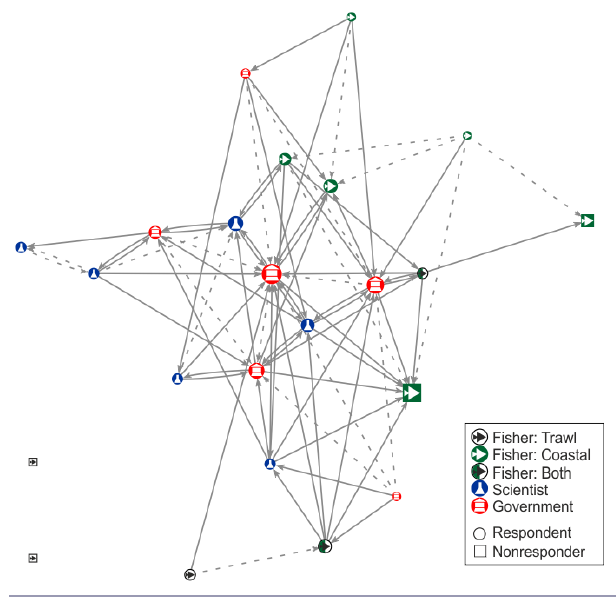
Fig. 2 . Sociogram of the discussion network with stakeholder type, Estonian Gulf of Riga Herring (node size represents number of nominations, within-group ties are